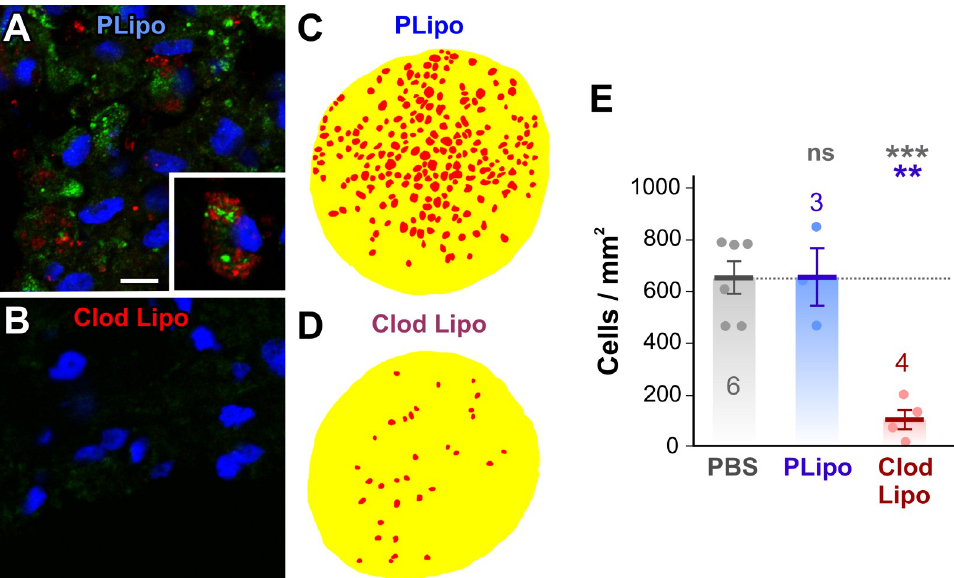
Fig 7. Clodronate liposomes deplete macrophage numbers. (A, B) Immunohistochemical staining of macrophages with anti-CD68 antibody in the optic nerve at 1 week after axotomy and treatment with (A) DiI-labeled liposomes and PBS (PLipo) or (B) with DiI-labeled clodronate liposomes (Clod Lipo). Nuclei are counter-stained with DAPI (blue). (A) Macrophages stained with CD68 (green) are also labeled to varying degrees with DiI-labeled liposomes (red). The inset shows a macrophage with particularly strong liposome uptake. Scale bar: 10 μ m. (B) Clodronate-liposome-treated nerve shows cells with only background staining with CD68, and no detectable DiI-liposome labeling. (C, D) Color overlays of light micrographs of transverse 1 μ m sections of the optic nerve taken from the region 100 μ m distal to the injury area at 1 week after axotomy and liposome treatment, delineating macrophage-like cell profiles (red) and the nerve itself (yellow). (E) Scatterplots of cell density showing mean ± SEM. Treatments are PBS alone, PBS liposomes (PLipo), or clodronate liposomes (Clod Lipo), at 1 week after axotomy. Numbers of animals are shown. Asterisks or “ns” above each column indicate the significance when compared to 1 week PBS control (row 1, gray), or 1 week clodronate liposomes (row 2, blue) with ANOVA and post-hoc Tukey tests. The macrophage cell density is unaffected by DiI-labeled liposome treatment alone. However, clodronate liposome treatment resulted in an 80% decrease in macrophage density.